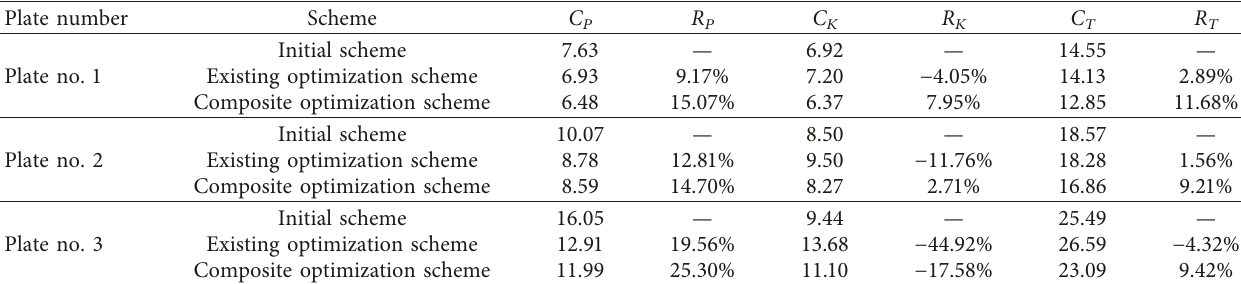
Table 8: Comparison of the total cost of materials for each scheme (units: ten thousand